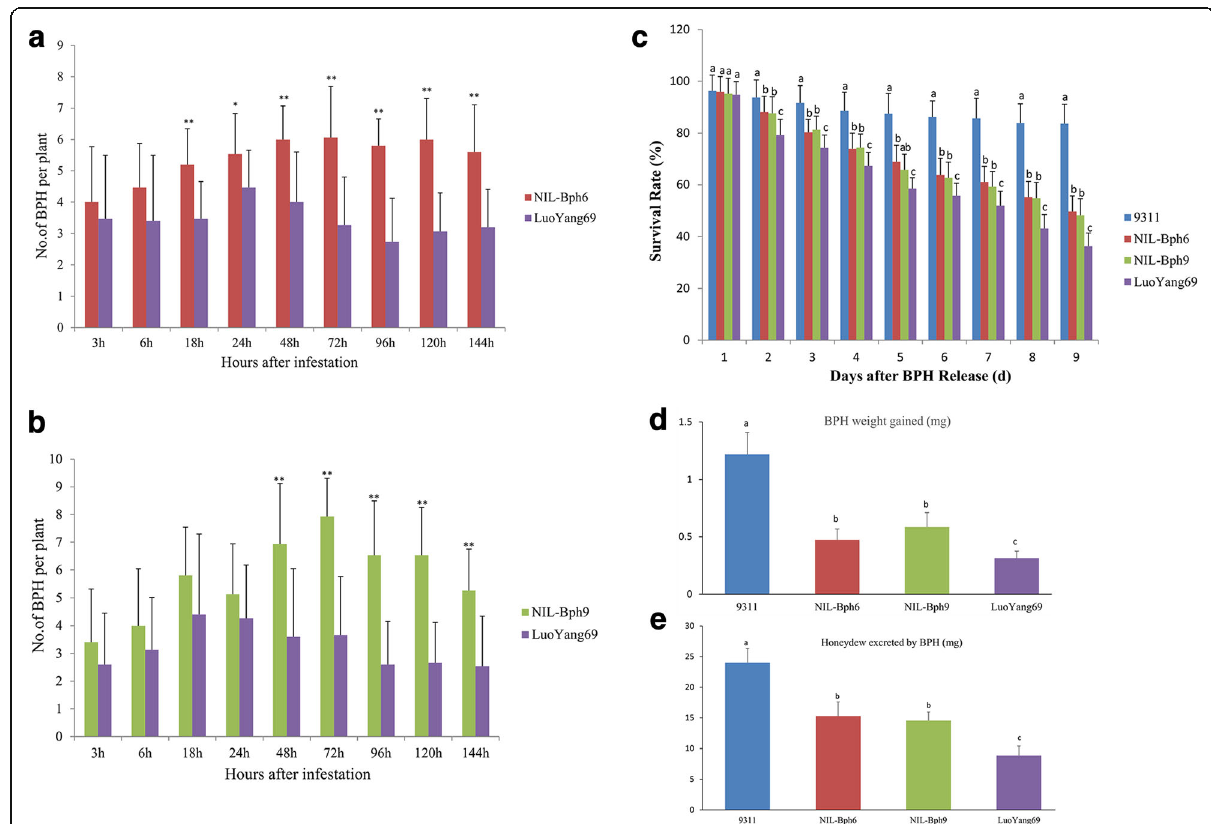
Fig. 3 Antixenosis and antibiosis effects of LuoYang69 on BPH insects. a Settling of BPH insects on LuoYang69 and on NIL- Bph6 in a two-host choice test. b Settling of BPH insects on LuoYang69 and on NIL- Bph9 in a two-host choice test. c BPH survival rate on LuoYang69, NIL-Bph6 , NIL-Bph9 and 93 – 11 in a non-choice feeding experiment, respectively. d Weight gain of BPH insects after feeding on LuoYang69, NIL-Bph6 , NIL-Bph9 and 93 – 11 for 48 h, respectively. e Measurement of honeydew excreted from BPH insects on LuoYang69, NIL-Bph6 , NIL-Bph9 and 93 – 11, respectively. a and b Bars represent means of 20 replicates. Error bars represent the SD. Means labeled with asterisks are significantly different ( P <0.05). Means labeled with double asterisks are extremely significant different ( P <0.01). c Bars represent means of 16 replicates. Error bars represent the SD. The different letters above the bars are significantly different at P <0.05 level. d and e Bars represent means of 21 replicates. Error bars represent the SD. The different letters above the bars are significantly different at P <0.05